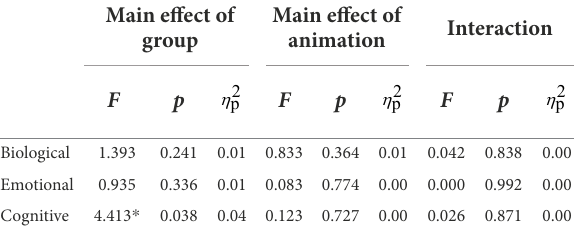
TABLE 2 Comparisons between children with and without ICs in agency attributions to ToM and random